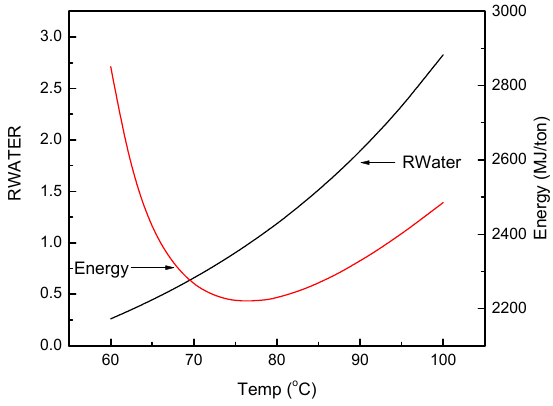
Figure 12. The effect of separation temperature on the FO process performance using DP as the draw solute.